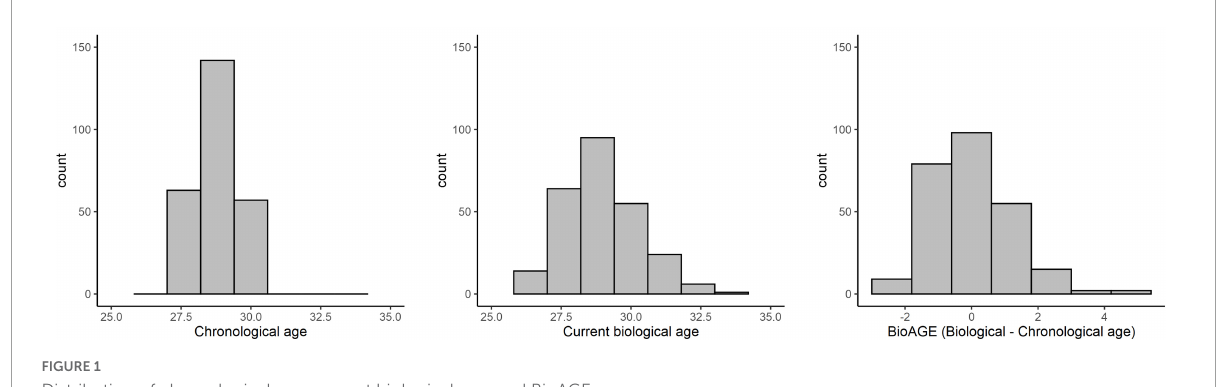
FIGURE1 Distribution of chronological age, current biological age, and BioAGE.